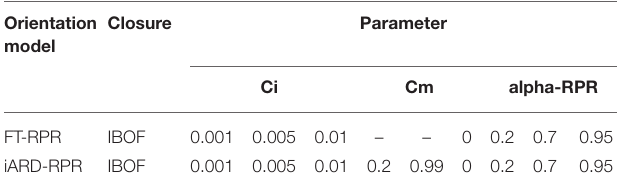
TABLE 2 | Simulation trials for ANOVA analysis.